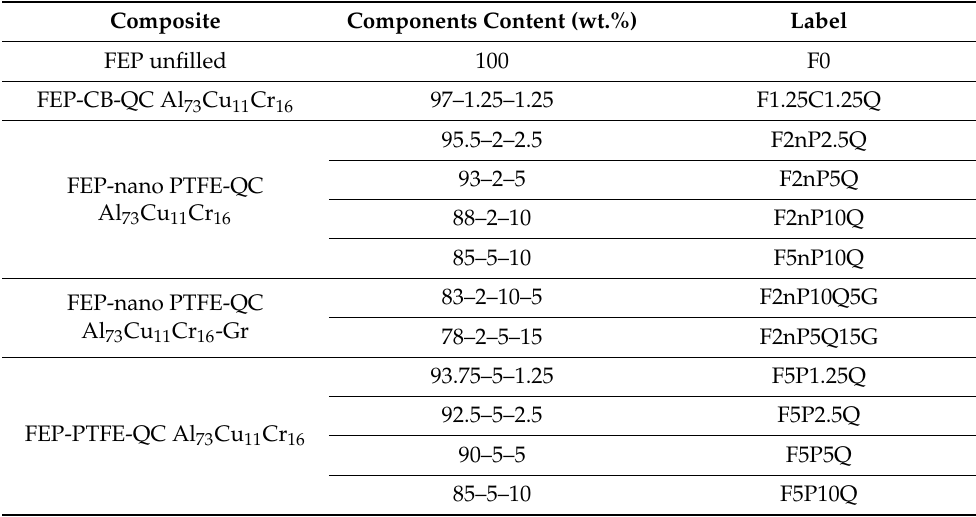
Table 1. The list of the obtained FEP-based compositions. Composite Components Content